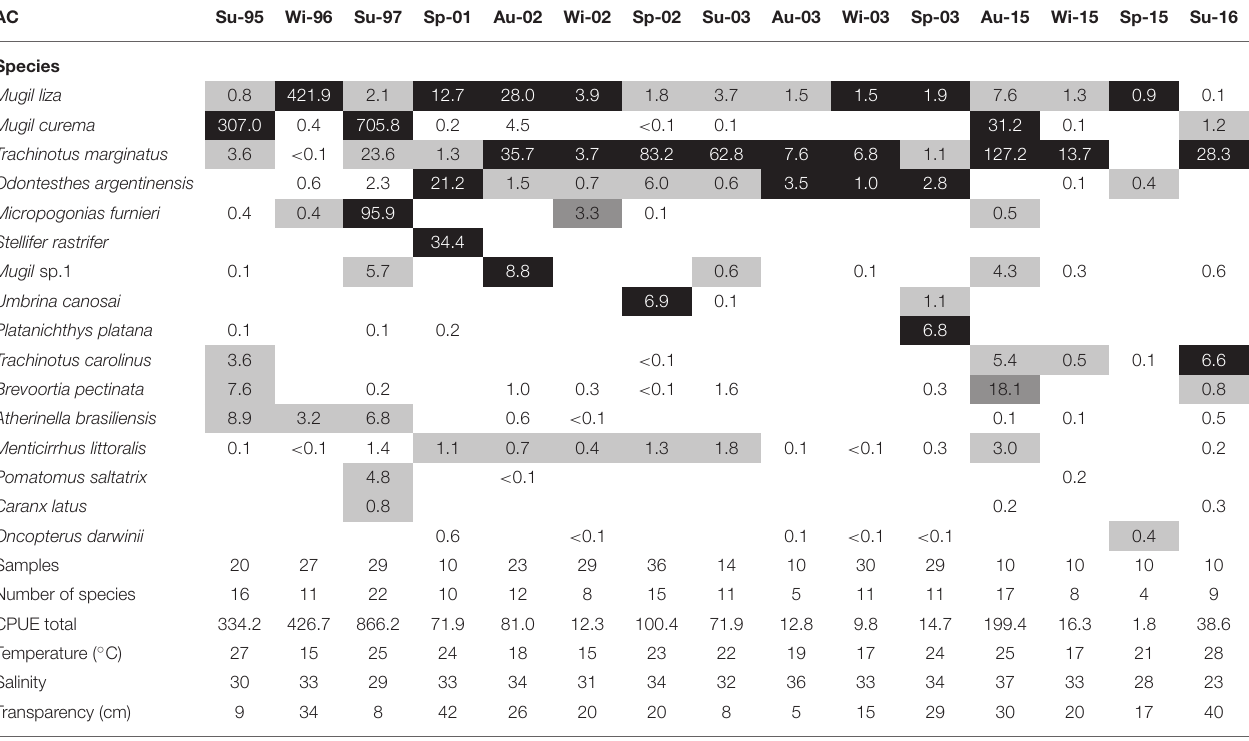
TABLE 1 | List of species caught per season per year in the marine adjacent coastal area (AC) and number of samples, number of species, total catch per unit effort (CPUE), mean temperature ( ◦ C), mean salinity and mean transparency